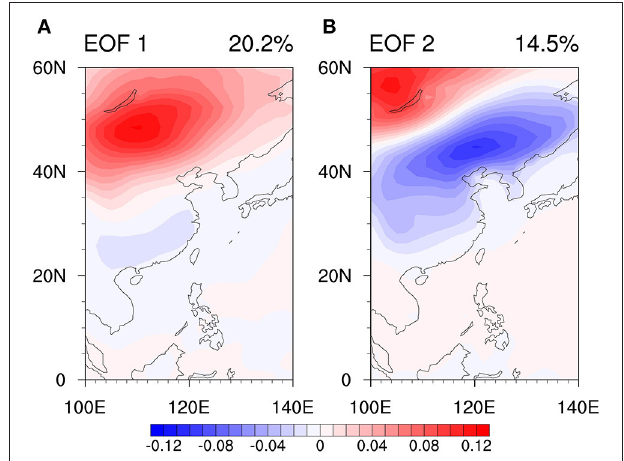
FIGURE 1 | The first EOF mode (A) and second EOF mode (B) of raw air temperature field at 2m (unit: K; with the annual cycle removed) in boreal